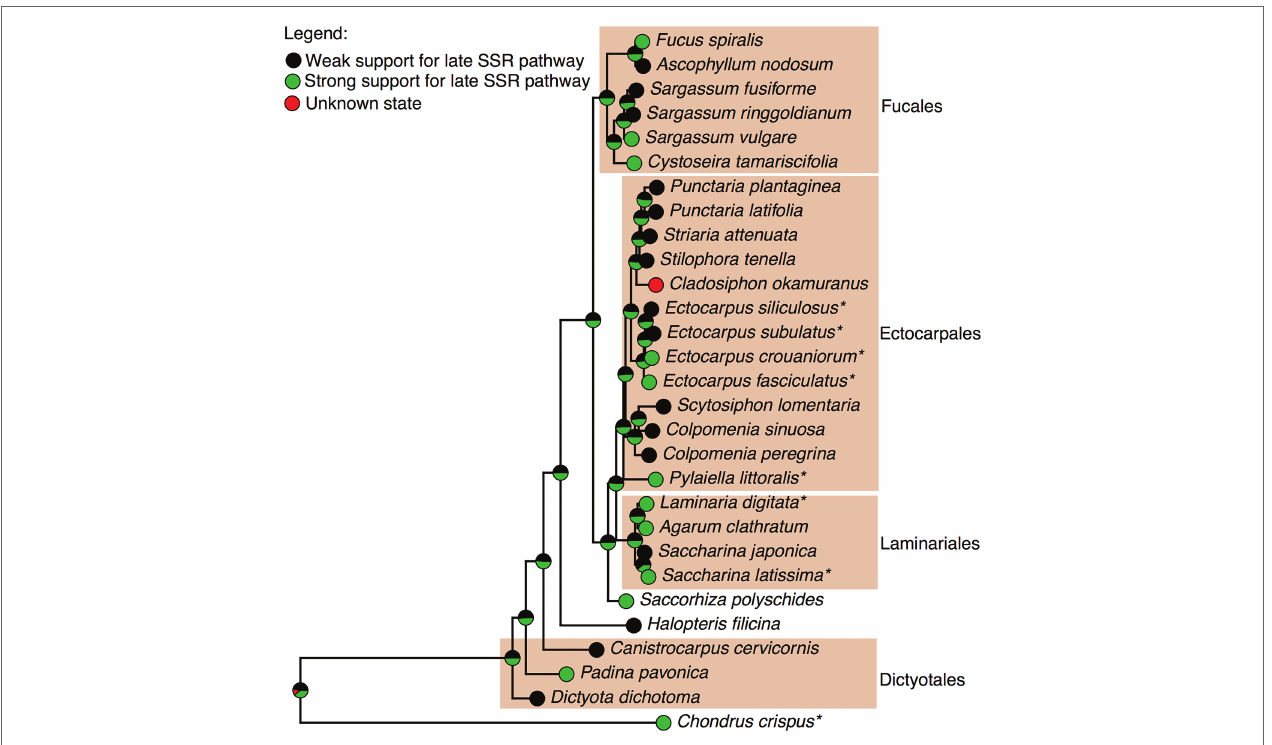
FIGURE 4 | Mapping the degree of support for the late SSR cholesterol pathway in brown algae. The maximum-likelihood tree was inferred based on publicly available data of the cox3 mitochondrial marker. The four color boxes indicate algal orders where multiple species were analyzed. Strong support: cholesterol and desmosterol detected. Weak support: only cholesterol detected. *represents species with GC-MS data reported in this